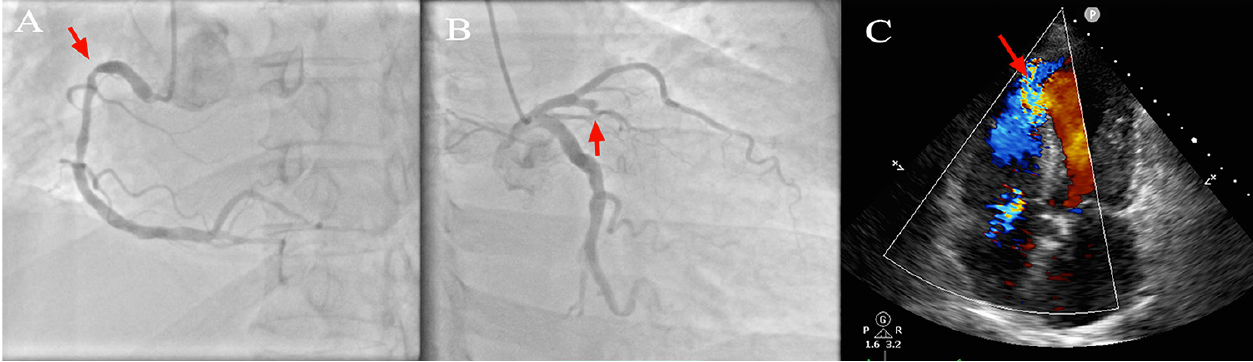
Fig. 1 - Diagnostic imaging. (A) Coronary angiography showing 80% obstruction of RCA (arrow) and (B) complete obstruction of the ADA (arrow). (C) 2D color echocardiographic image of apical VSD (arrow).